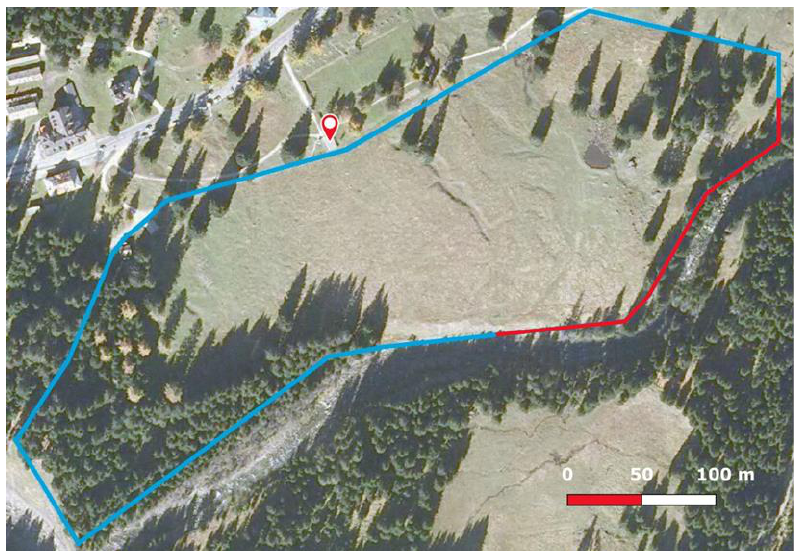
Figure 1. Aerial photo of the enclosure. On the left, a woodland is present, and the central part is an open pasture, and, on the right, a small lake is present. The blue line represents the easily walkable perimeter of the enclosure, while the red line corresponds to the less accessible path; mark shows the observation platform. Tourists are allowed to walk around the whole perimeter of the enclosure, with some easily walkable parts and some less accessible ones. Tourists are not allowed to enter the enclosure and their presence is variable depending on the day of the week, time of day and month. An observation platform is present, allowing the observation of the animals from a respectful distance (Figure 2).